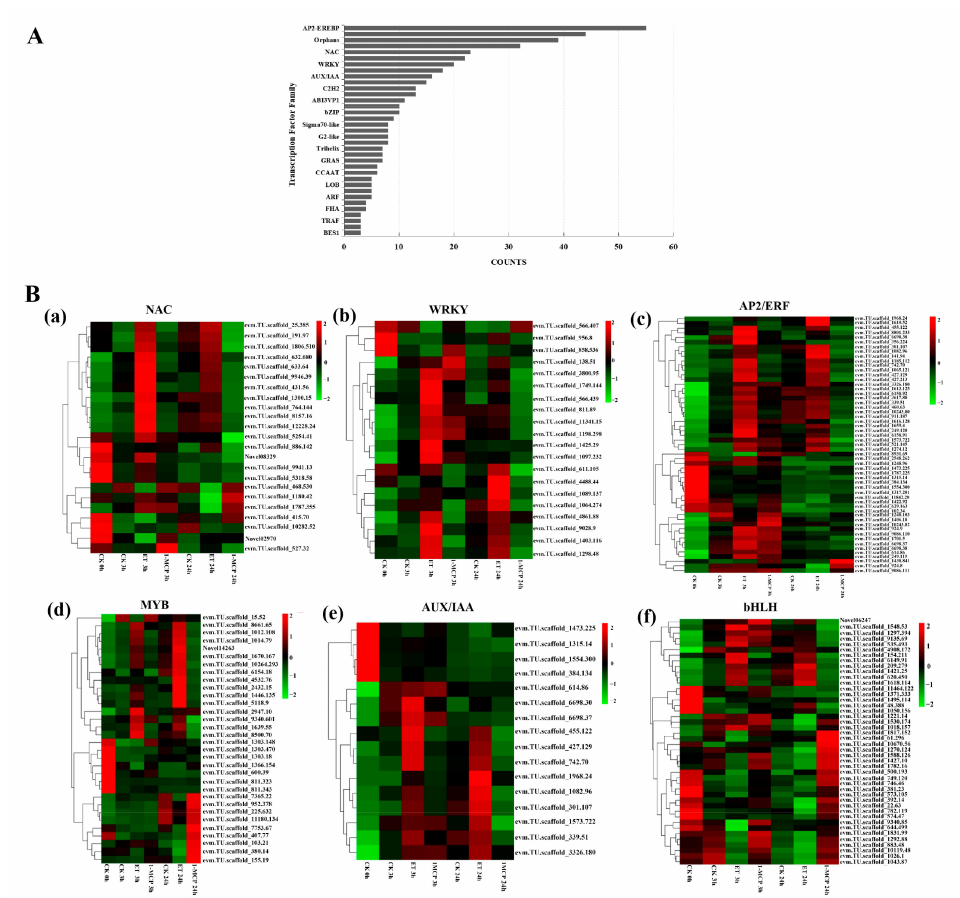
Figure 5. Identification of transcription factors (TFs) differentially expressed with ethylene and 1-MCP treatment. ( A ) Distribution of transcription factor family members in differentially expressed genes. ( B ) Heatmap analysis of transcription factor family genes in post-harvest cut chrysanthemum in response to ethylene treatment. ( a ) NAC ; ( b ) WRKY ; ( c ) AP2 / ERF ; ( d ) MYB ; ( e ) AUX / IAA ; and ( f ) bHLH . Red represents high expression and green represents low